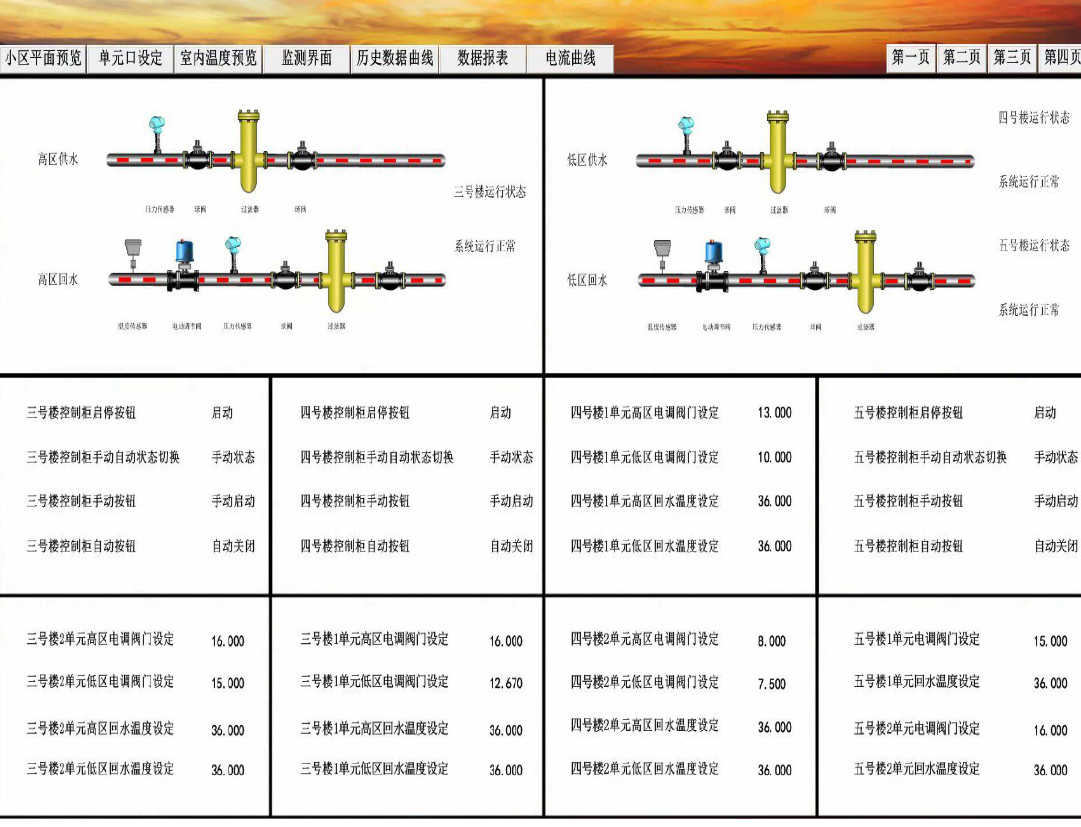
Fig. 9 SCADA system’s human-machine exchange interface. SCADA, supervisory control and data